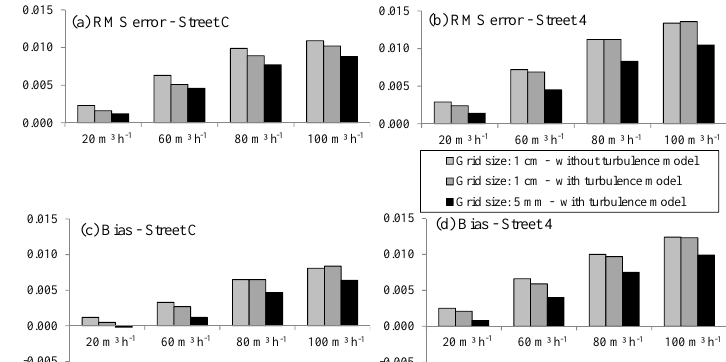
Figure 7. Bias and root mean square error (RMSE) on the computed water depths in streets C and 4.